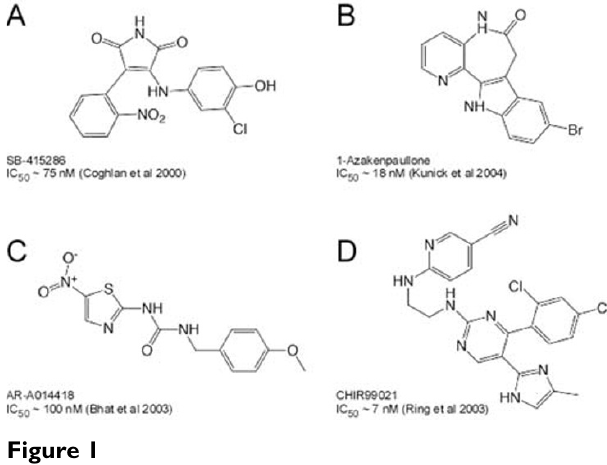
Figure 1 Small molecule inhibitors of GSK-3 . Chemical struc- tures of SB-415286, 1-Azakenpaullone, AR-A014418 and